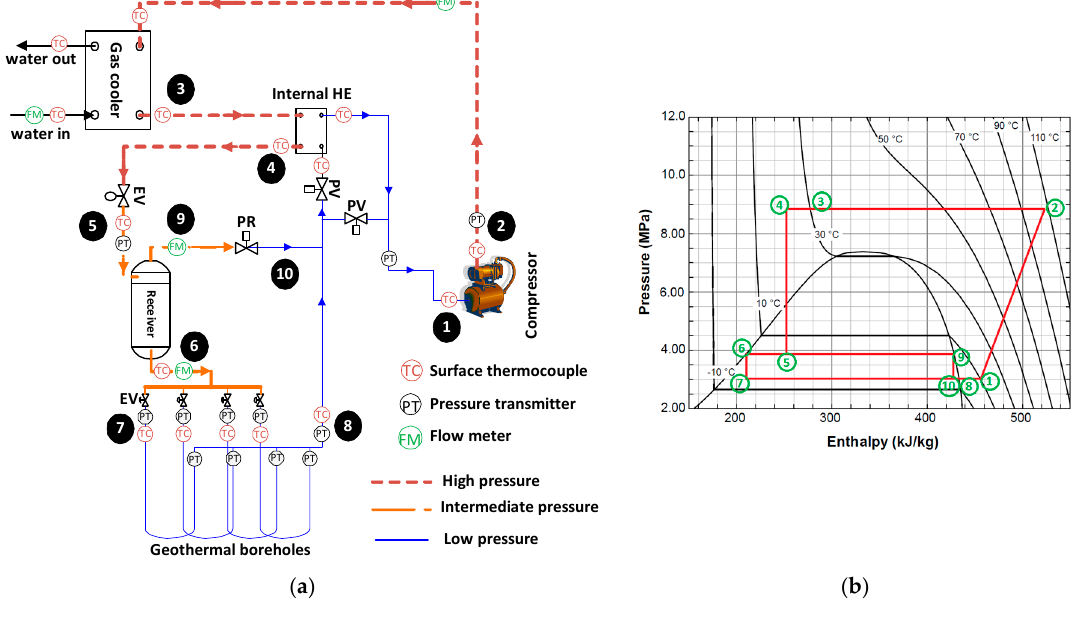
Figure 1. ( a ) System schematic; ( b ) Cycle P ‐ h diagram.